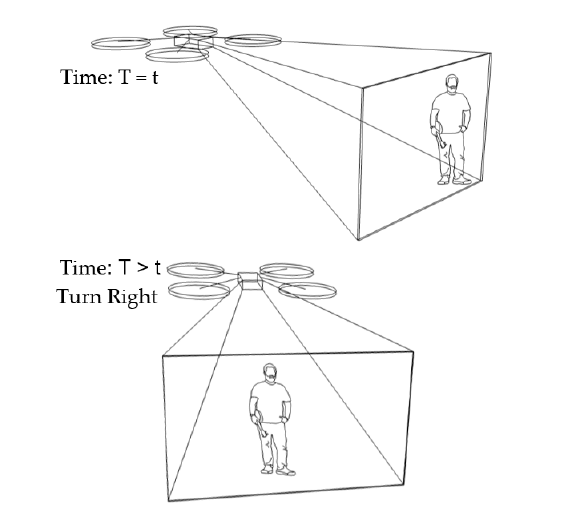
Figure 8. Human motion tracking when the drone turns